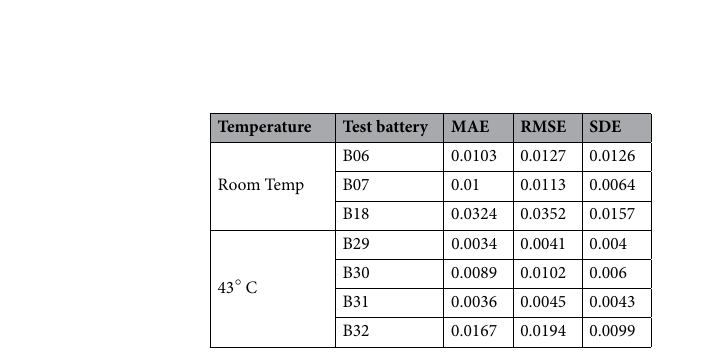
Table 4. SOH estimation results for NASA data.